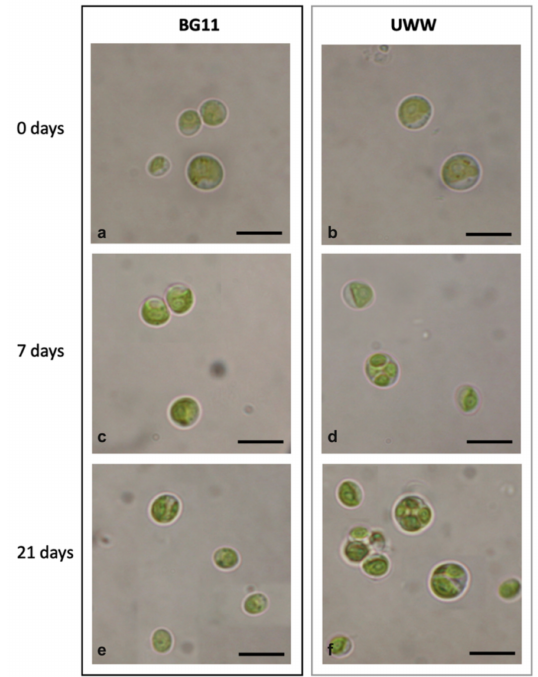
Figure 5. Light microscopy view of microalgae cultivated in modified BG11 and UWW at 0, 7 and 21 days of cultivation. ( a , c , e ) Cells in synthetic BG11 medium. ( b , d , f ) Cells in UWW effluent. Bars, 4 µ m.